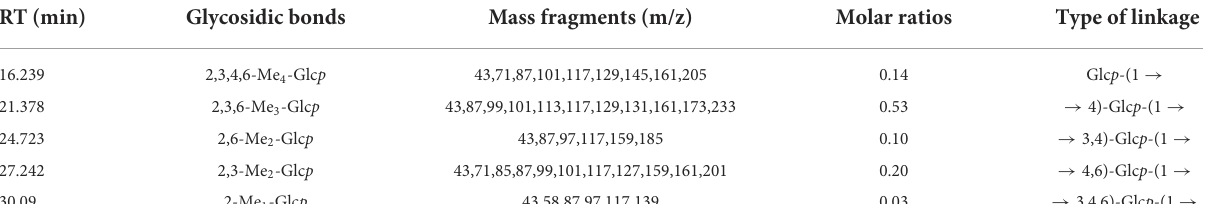
TABLE 2 Glycosidic bonds and types of linkage in CAG-1.